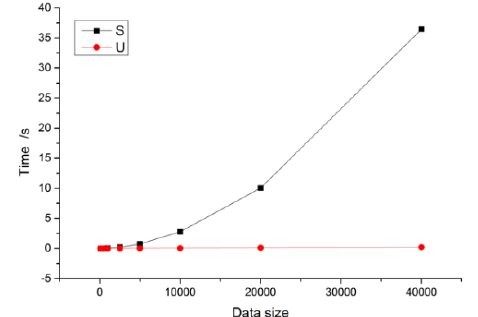
Figure 4. Running-time experiment of Silhouette coefficient and uncertainty coefficient